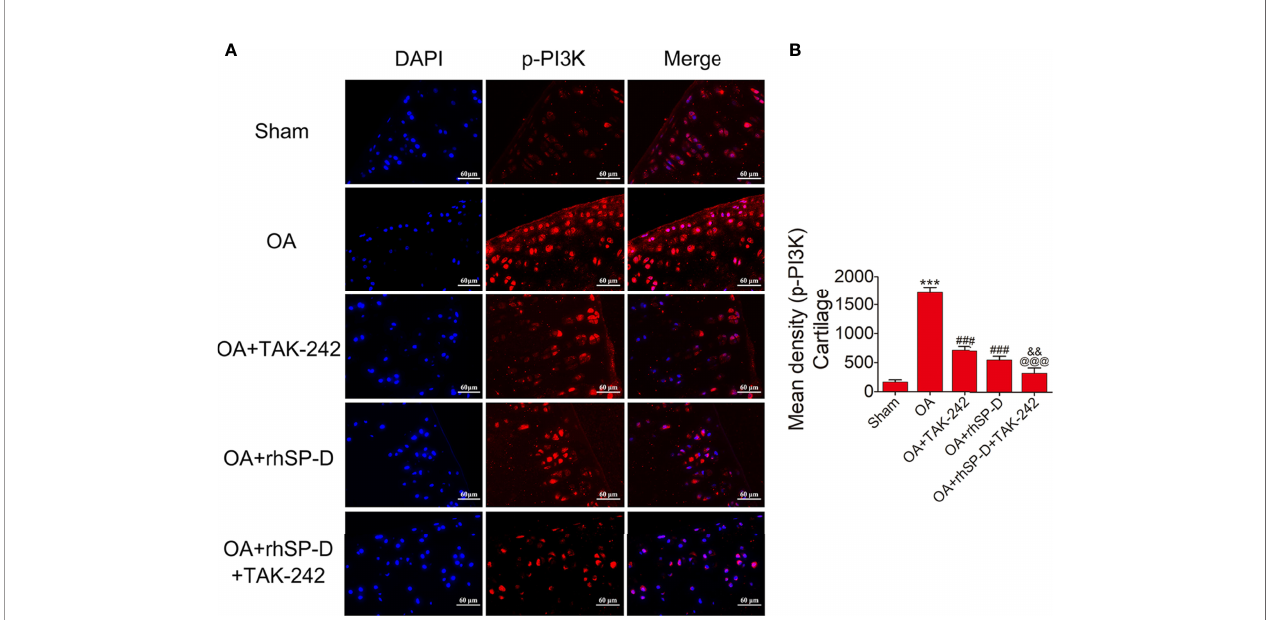
FIGURE 5 | Suppression of TLR4-mediated PI3K signaling by SP-D treatment in vivo . (A) Immuno fl uorescence with an antibody to p-PI3K in articular cartilage from the ACLT + MMx-induced OA rats with rhSP-D and TAK-242 treatment at 10 weeks post-surgery. (B) The ratios of immunoreactive cells were quanti fi ed in articular cartilage according to immuno fl uorescence. Data were expressed as mean ± SEM (n = 5). ***P < 0.001 vs. the sham-operated group; ### P < 0.001 vs. the OA- induction group; && P < 0.01 vs. OA + rhSP-D group; @@@ P < 0.001 vs. OA + TAK-242 group.